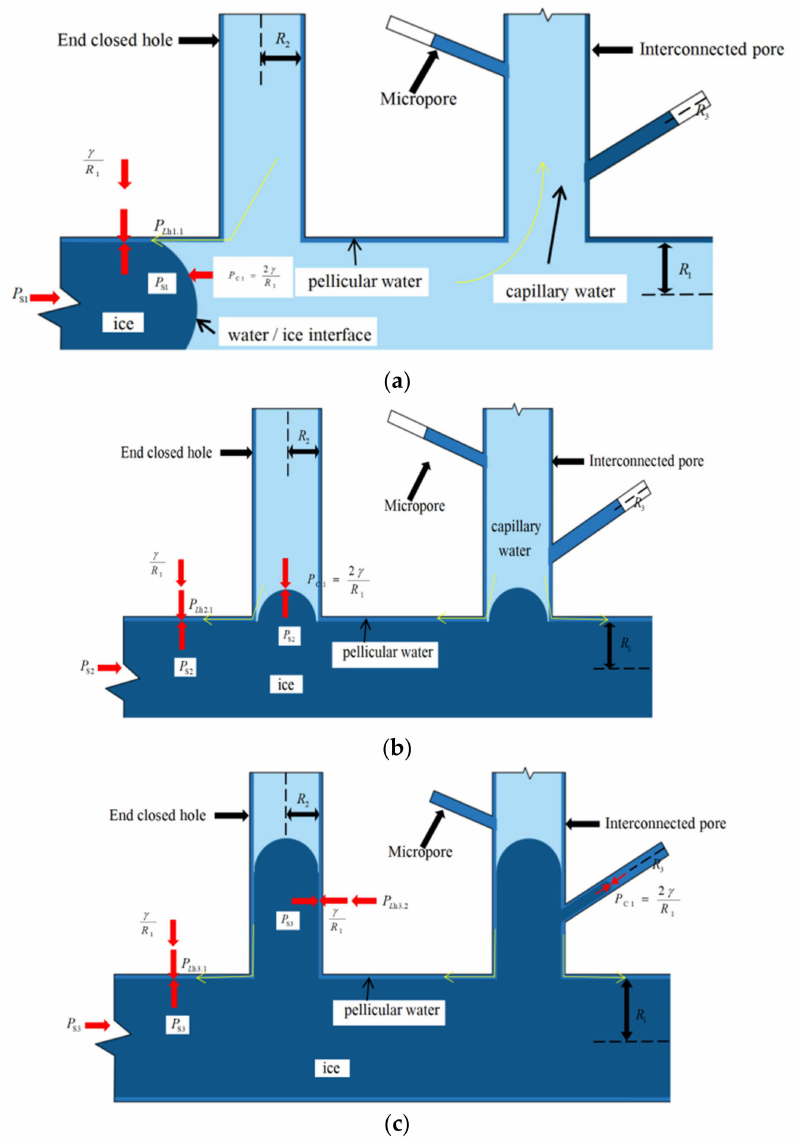
Figure 12. Water transport model. ( a ) macropore freezing; ( b ) mesoporous freezing; ( c ) microp- ore